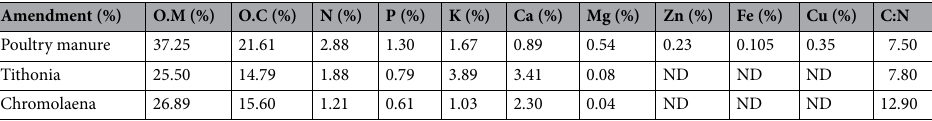
Table 2. Chemical composition of the amendments used. O.M organic matter, O.C organic carbon, ND not detected.